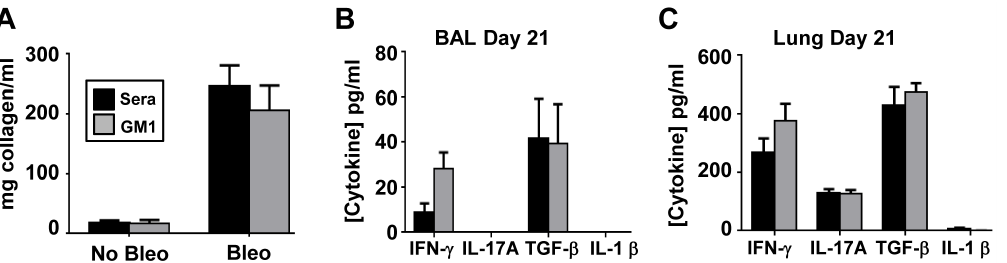
Figure 8. Anti-asialo GM1 treatment during the fibrotic phase of BIPF does not alter fibrosis development. ( A ) BAL collagen concentration was measured using the Sircol assay. IL-1 b , TGF- b , IFN- c , IL-17A levels were measured by ELISA in ( C ) BAL fluid or in ( D ) lung homogenates from mice treated with control sera control or anti-asialo GM1. Mean 6 SEM of n=5 mice per group.